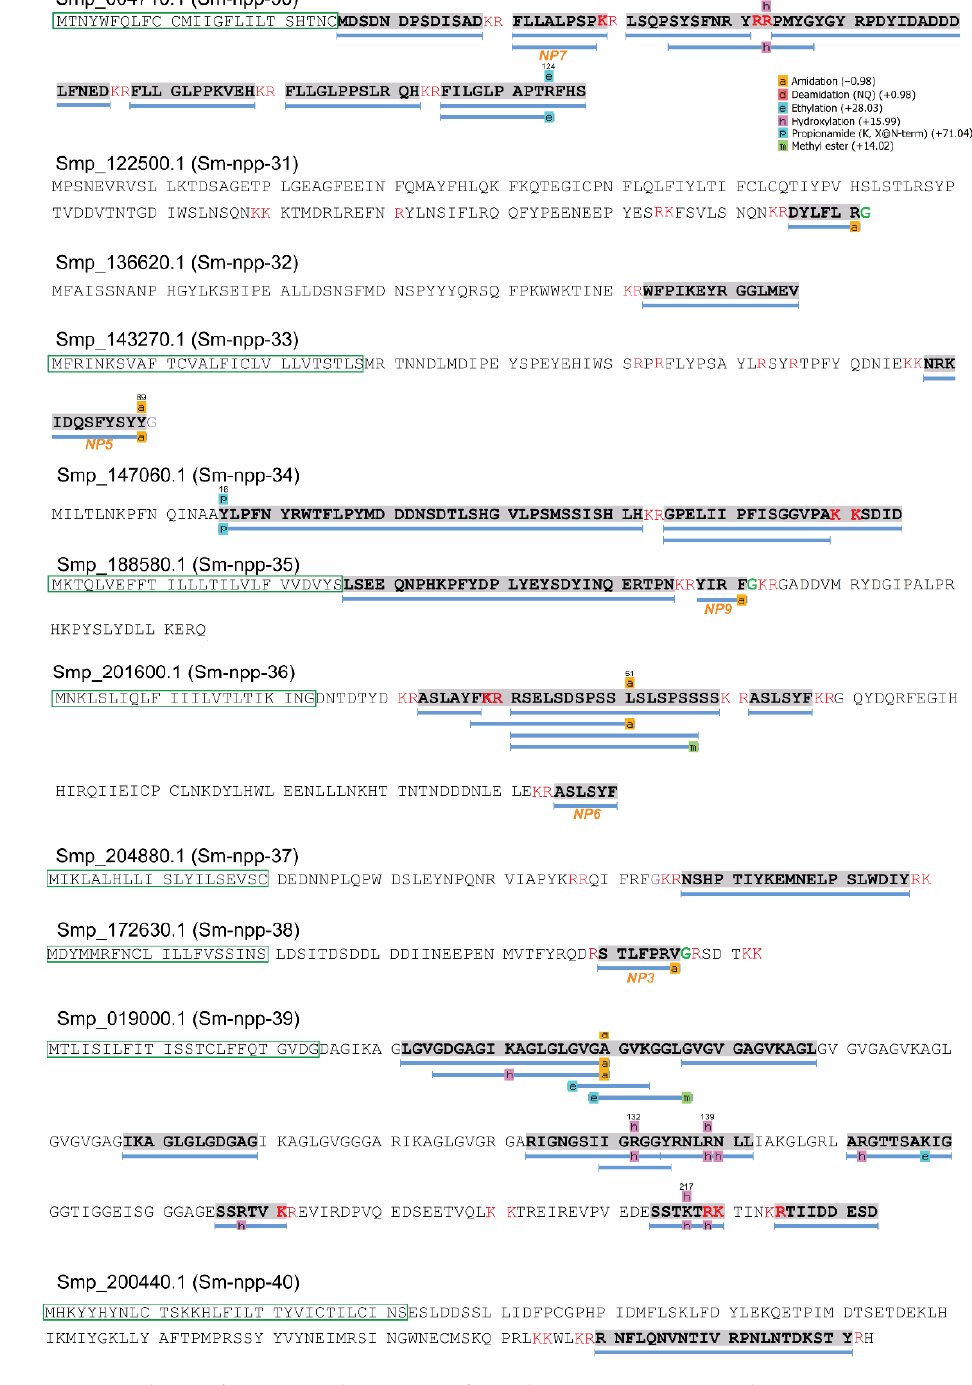
Figure 2. The MS/MS spectral coverage of novel putative neuropeptide precursors in S. mansoni cercariae. The peptide segments, supported by high-confidence MS/MS spectra (supported by at least 5 consecutive b or y ions), are displayed in grey shade and underlined with blue bars. The PTMs were predicted by the PEAKS studio based on the database search results. Predicted signal peptides are shown with a green frame; cleavage sites are in red font; glycine residues available for C-terminal amidation are in green font. Putative neuropeptides employed in the behavioural bioassay are underlined with their corresponding